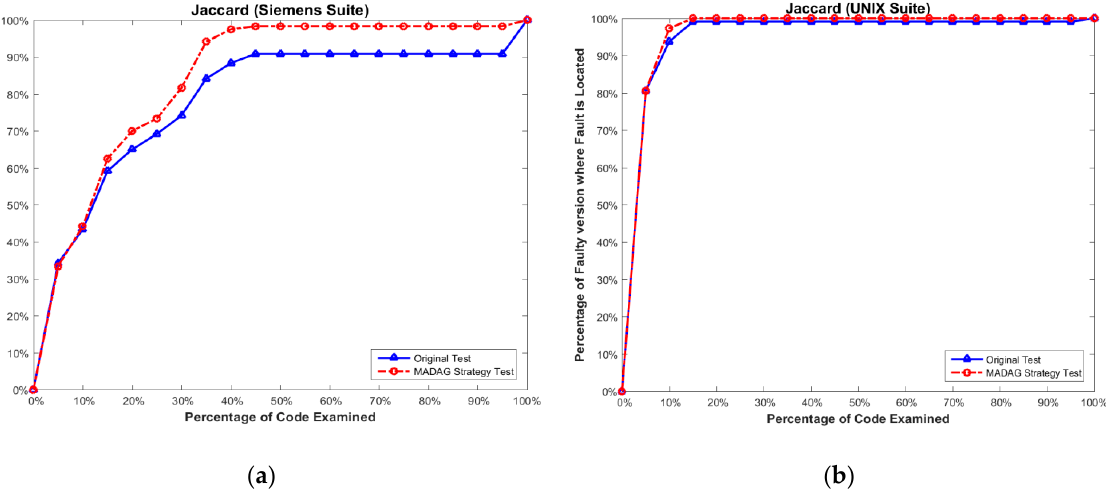
Figure 7. ( a ) Effectiveness comparison on the Siemens suite for Tarantula ; and ( b ) on the UNIX suite for Tarantula .